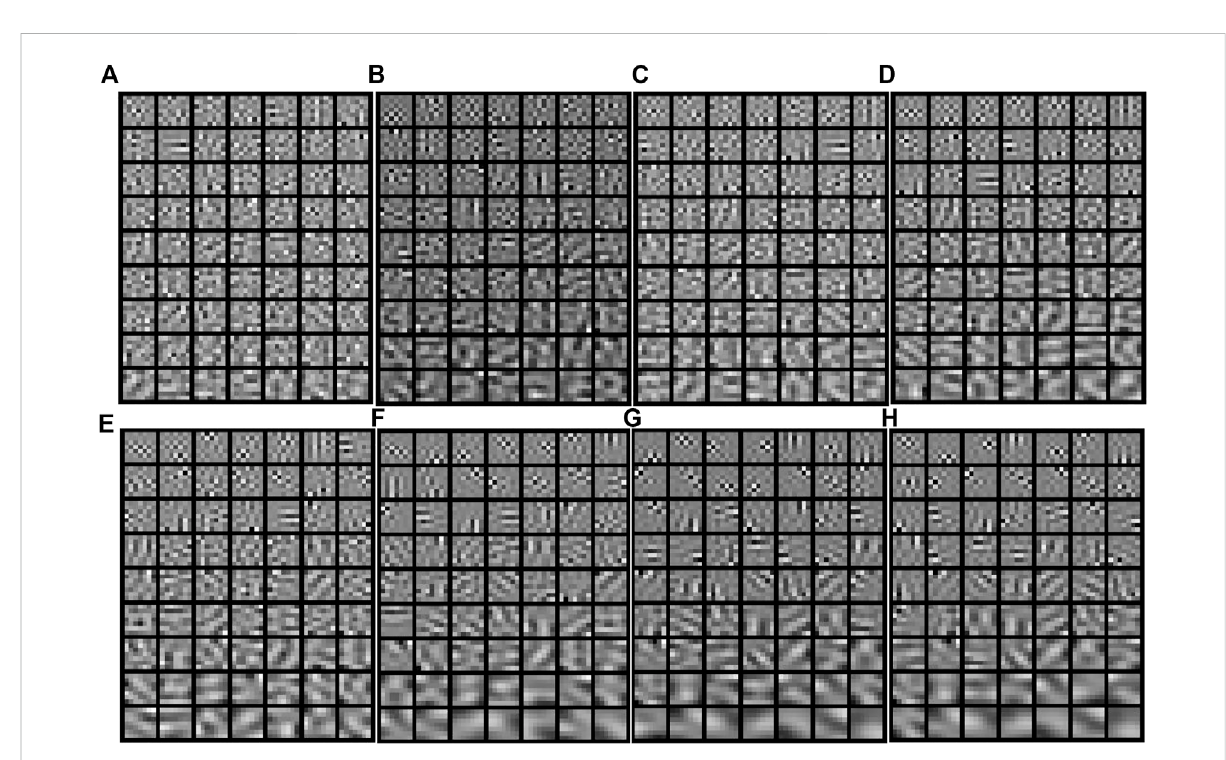
FIGURE 3 Partial dictionary images in different iterations. (A) Partial dictionary images in 5th iterations ( E (cid:1) 17 . 57); (B) Partial dictionary images in 10th iterations ( E (cid:1) 15 . 85); (C) Partial dictionary image in 15th iterations ( E (cid:1) 14 . 16); (D) Partial dictionary images in 20th iterations ( E (cid:1) 10 . 23); (E) Partial dictionary images in25th iterations ( E (cid:1) 6 . 89); (F) Partial dictionaryimages in30th iterations ( E (cid:1) 3 . 82); (G) Partial dictionaryimages in35th iterations ( E (cid:1) 1 . 22); (H) Partial dictionary images in 40th iterations ( E (cid:1) 0 .